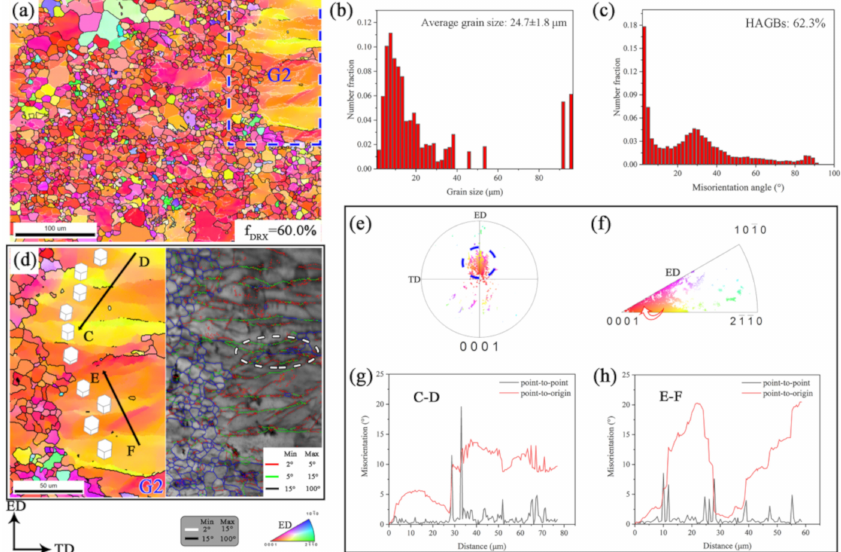
Figure 6. EBSD results of 3 passes of the CEE-AEC-processed sample: ( a ) inverse pole figure map; ( b ) grain size distribution; ( c ) misorientation angle distribution; ( d ) inverse pole figure map of the region in ( a ), G1, and the corresponding crystallographic orientations shown in the (0001) pole figure of ( e ) and the inverse pole figure of ( f ); and ( g , h ) line profile of misorientation angle along CD and EF,